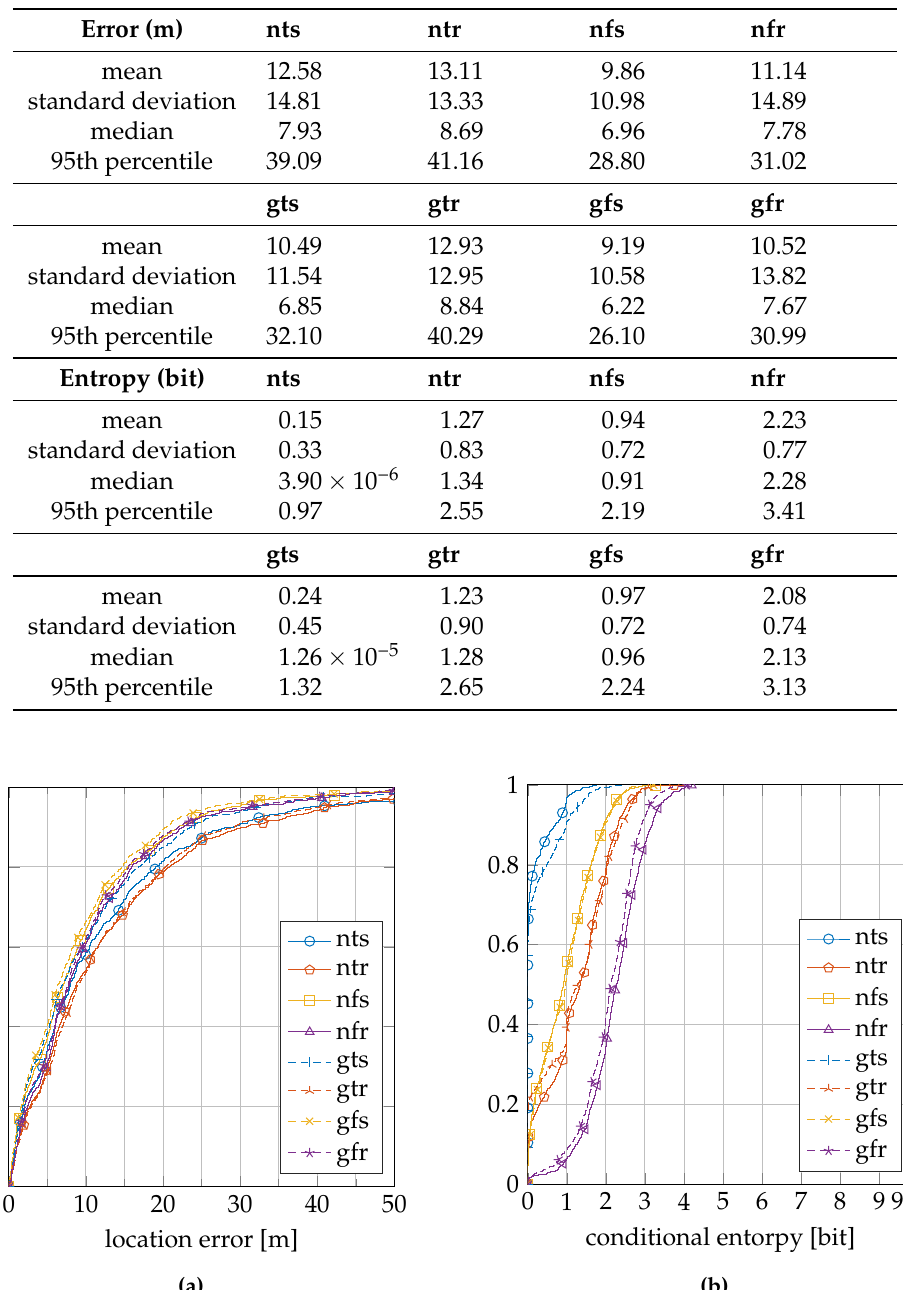
Table 5. UJIIndoorLoc summarizing table. The column labels refer to using the normal sensor model (n) or using the convolution sensor model (g), using the trained σ (t) or using the fixed σ (f) and using a single reference location for training (s) or using a region of reference locations for training (r).